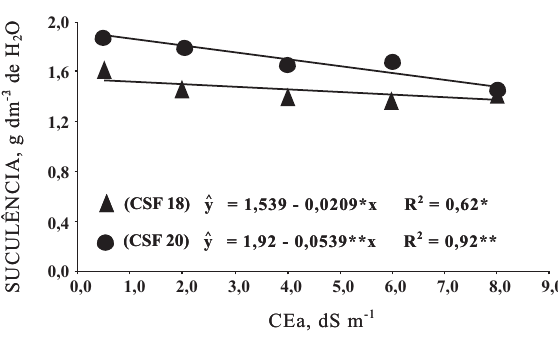
Figura 4. Grau de suculência foliar de plantas de dois genótipos de sorgo forrageiro irrigadas com água com crescentes concentrações de sais e com diferentes condutividades elétricas